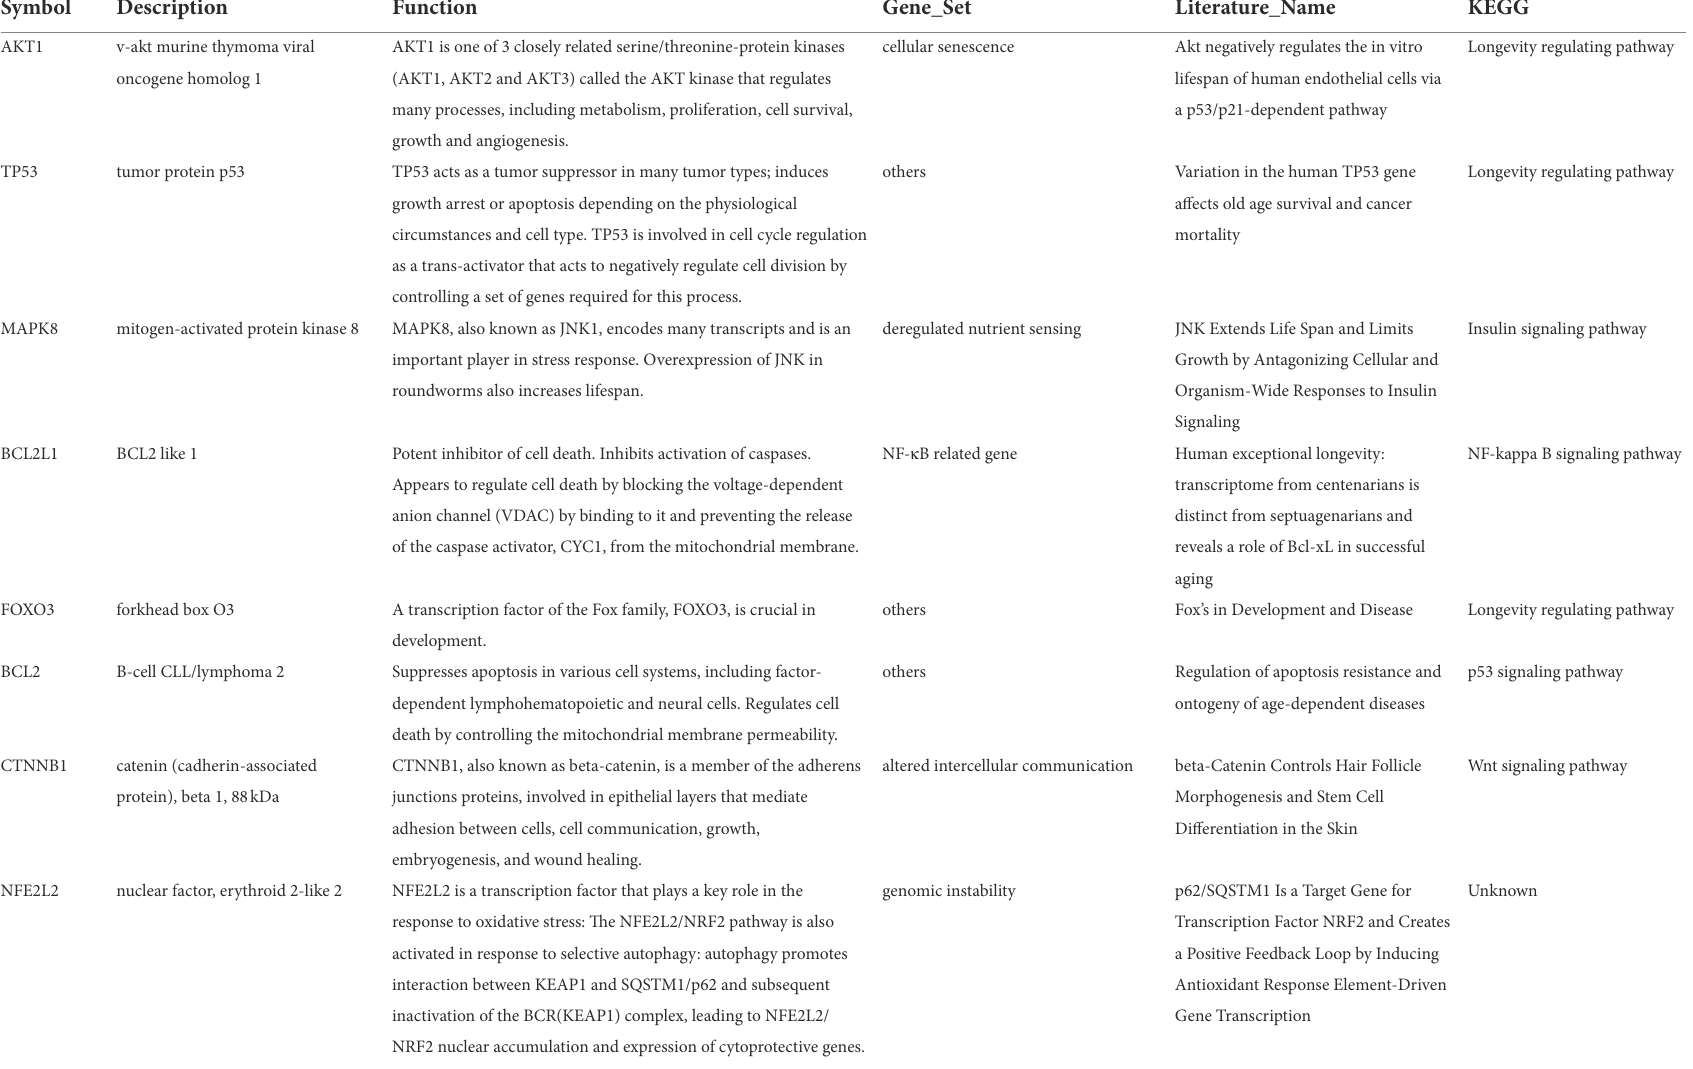
TABLE 1 Core targets of Cordycepin-anti-Alzheimer and pathways related to aging.